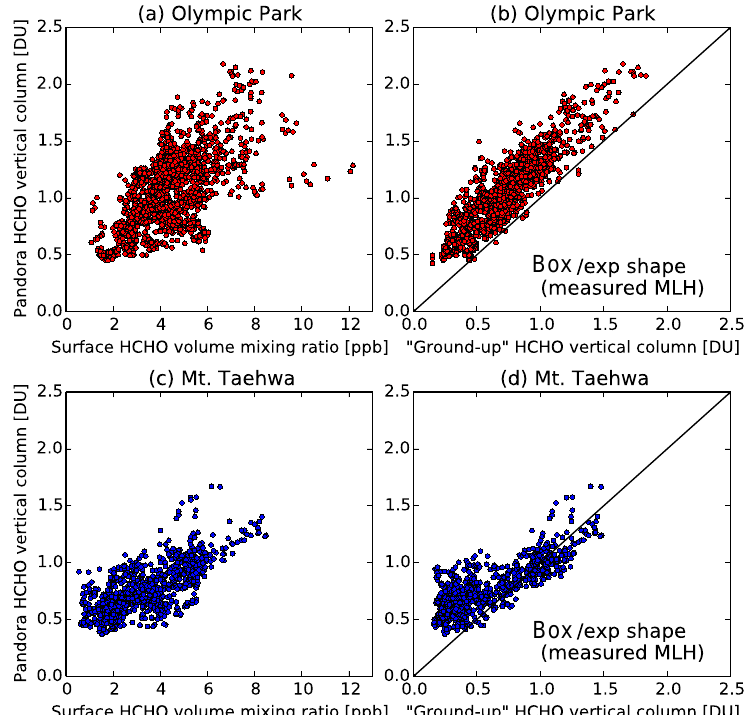
Figure 11. Pandora-measured HCHO vertical column densities vs. surface in situ mixing ratios and columns calculated from the surface vmr at Olympic Park and Mt. Taehwa during KORUS-AQ (May–June